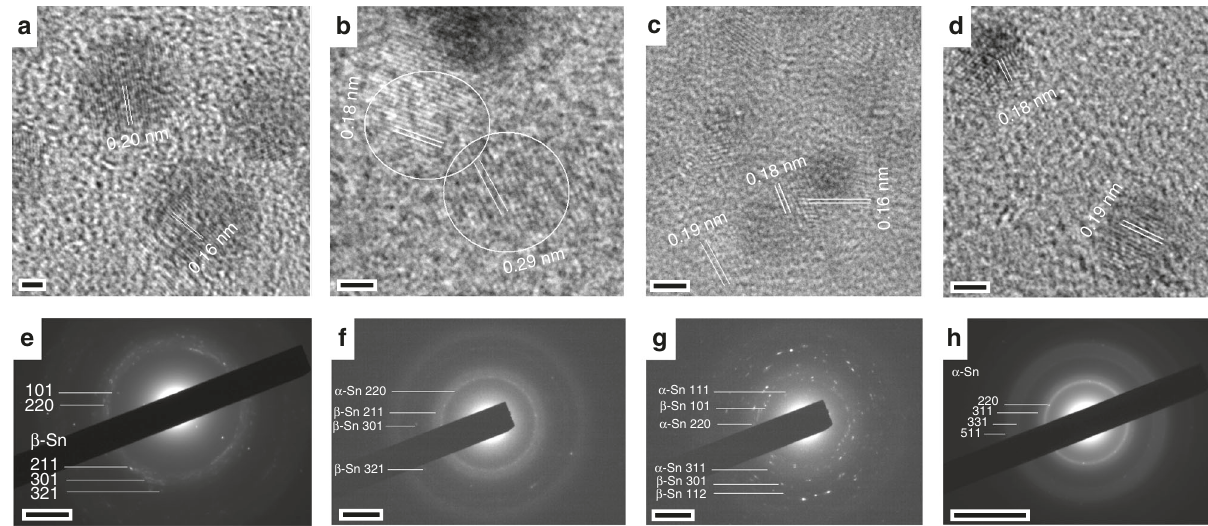
Fig. 3 Crystal structural transformations in tin nanocrystals. a – d Representative high-resolution transmission electron micrographs corresponding to Sn nanocrystals (NCs) prepared at 0.25 sLm, 0.5 sLm, 0.75 sLm and 1.0 sLm and with corresponding average diameter of 6.07, 2.32, 2.18 and 1.60 nm; ( e – h ) representative selected area electron diffraction patterns of the Sn NCs. The scale bars in ( a – d ) is 2 nm, in ( e – g ) is 2 nm − 1 and in ( h ) is 5 nm −